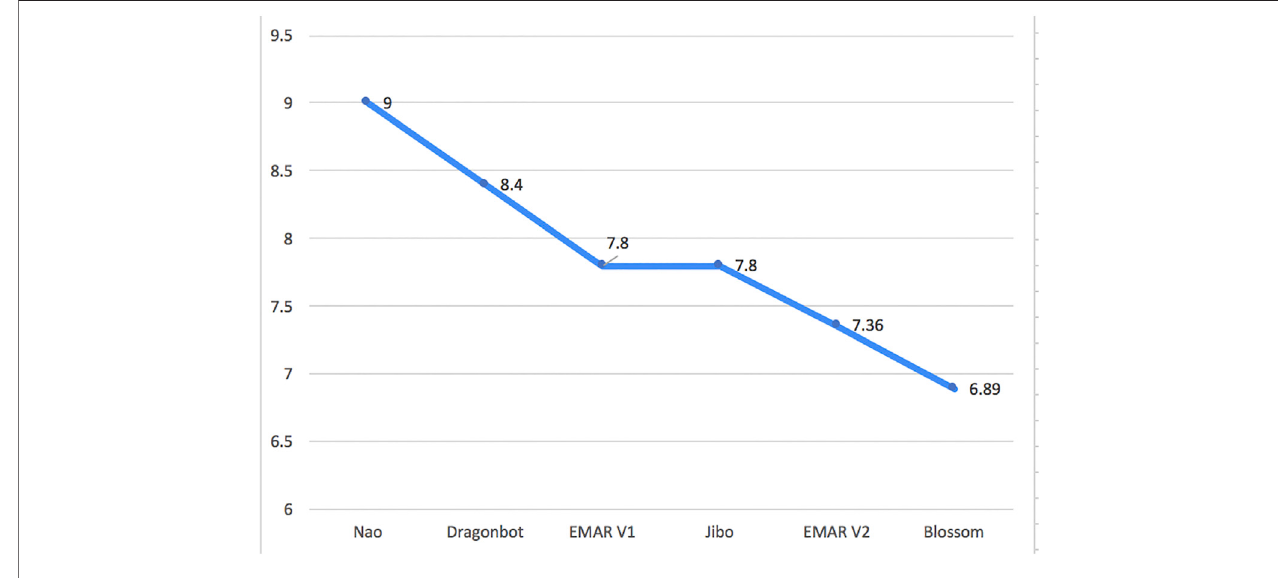
FIGURE 6 | Illustration of students ’ robot preferences by mean age.